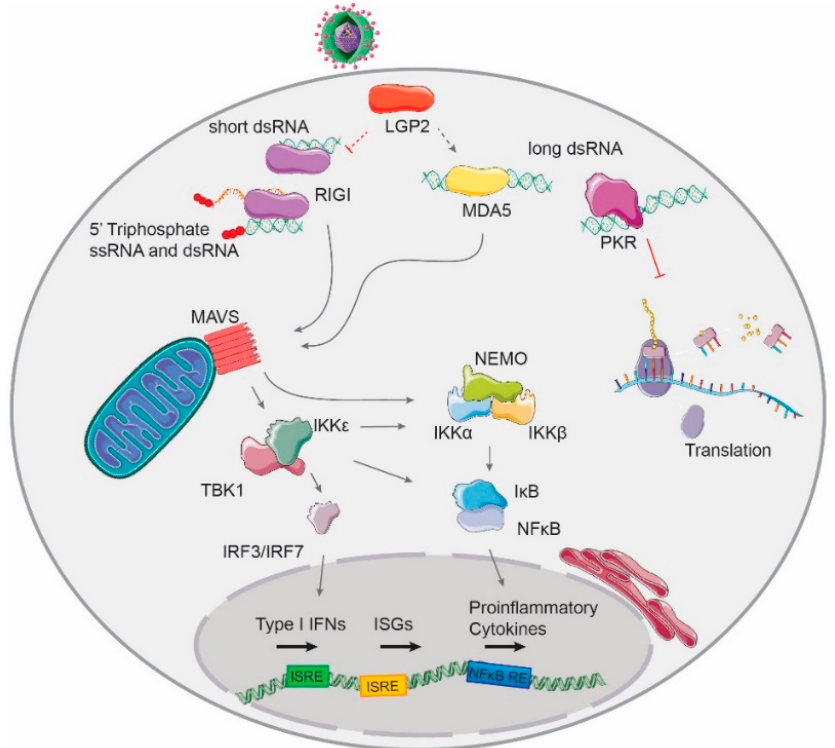
Figure 1. The typical hallmark of viral replication, dsRNA, is recognized by the RLR family of receptors in the cytoplasm of infected cells. RIG-I recognizes short dsRNA molecules with 5 ′ tri- and diphosphates; MDA5 recognizes long dsRNA molecules. Both MDA5 and RIG-I signal through the mitochondrial-associated factor MAVS to activate the transcription of type I interferons (IFNs) and pro-inflammatory cytokines. The third member of the RLR family, LGP2, modulates the activation of RIG-I and MDA5-mediated signaling pathways. The presence of dsRNA activates the host translational shut-off response through phosphorylation of the translation factor eIF2 α by the kinase